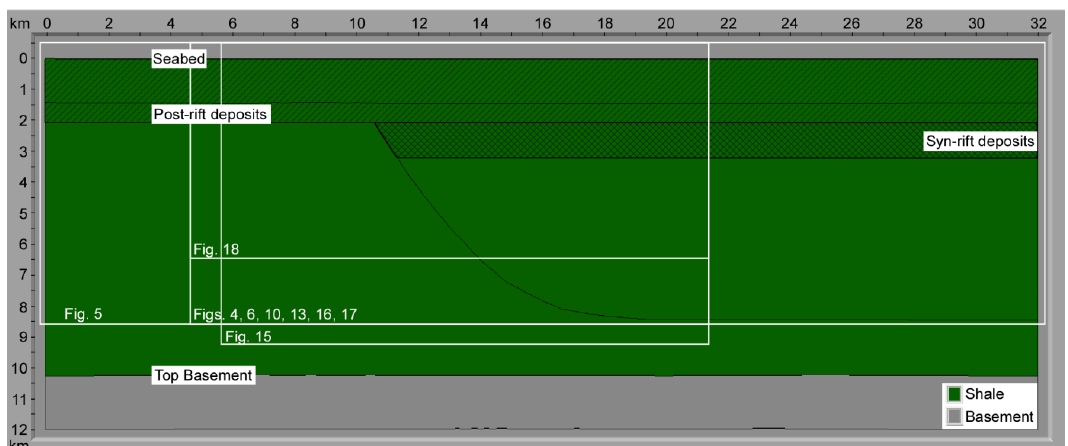
Figure 1. The synthetic profile with one active, listric fault used in the modeling. The green color (in this case) represents shale lithology. White squares indicate the blow-up area of following figures.